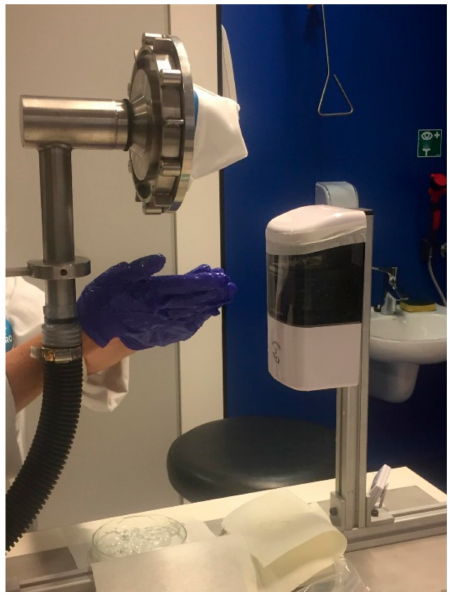
Figure 2. Experimental setup for exposing respirator test samples to alcoholic vapor (EtOH) emitted by an automatic hand sanitizer dispensing station via the release and use of gel hand